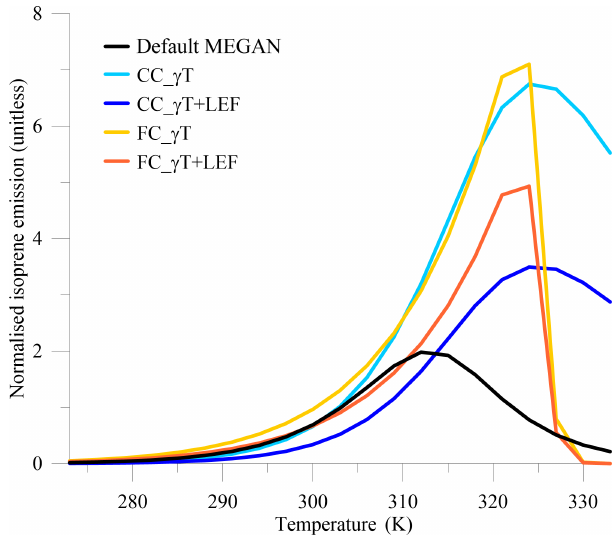
Figure 3. Impacts of new MEGAN variables on normalised iso- prene emission rates at increasing ambient